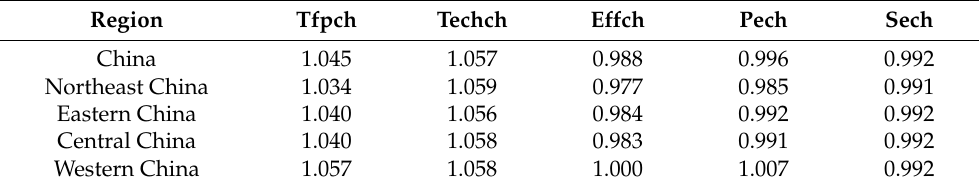
Table 3. Agricultural Tfpch and its decomposition factors in four major regions of China. Region Tfpch Techch Effch Pech Sech China 1.045 1.057 0.988 0.996 0.992 Northeast China 1.034 1.059 0.977 0.985 0.991 Eastern China 1.040 1.056 0.984 0.992 0.992 Central China 1.040 1.058 0.983 0.991 0.992 Western China 1.057 1.058 1.000 1.007